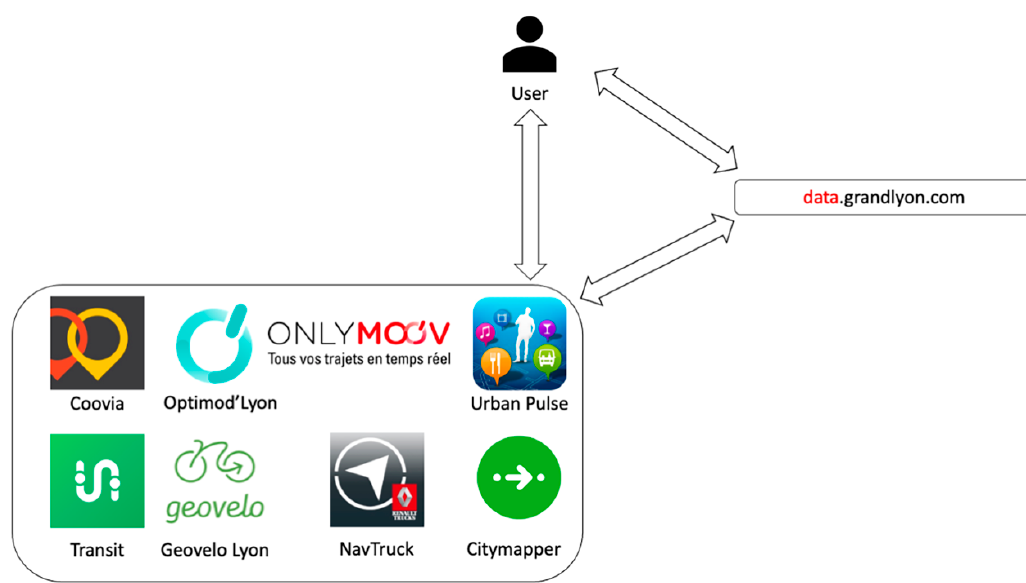
Figure 7. Examples of internal and external applications that have access to the data platform in Lyon [14].